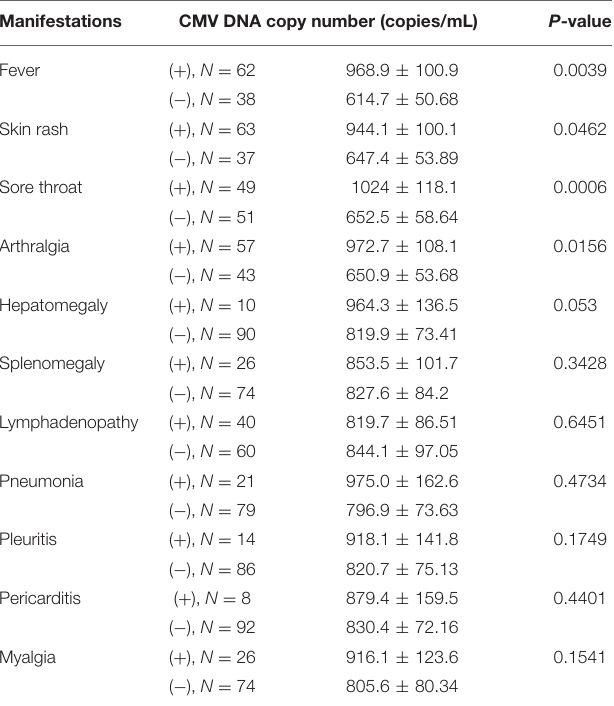
CMV DNA copy number are shown as mean ± SD, and differences between two groups were analyzed using the Mann-Whitney U test for nonparametric data.